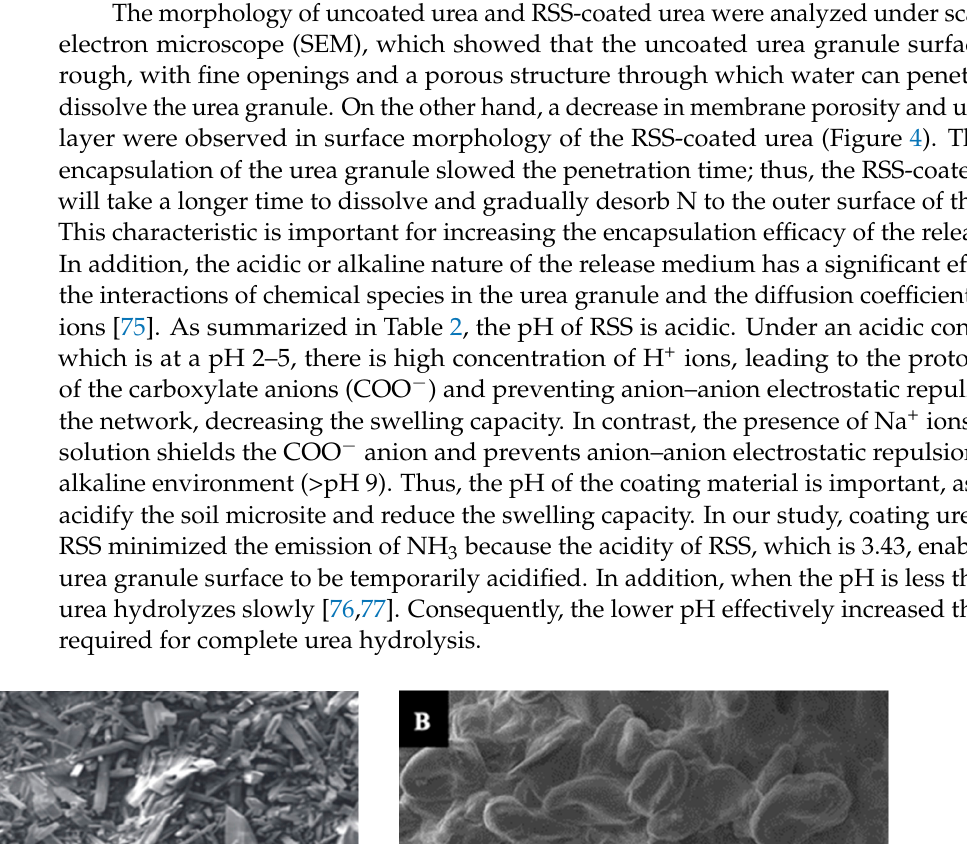
Figure 5. Di ff usion mechanism of nitrogen released from coated urea. After the release of NH 4+ in the soil, Figure 6 depicts the availability of NH 4+ for plant uptake, leading to increase in the NUE and minimizing the frequency of N fertilizer ap- plication. In addition, the coated urea mitigates N loss through the volatilization of NH 3 and the emission of nitrous oxide (N 2 O) in such a way that the coating serves as a nitri fi - cation inhibitor, which reduces the rate of nitri fi cation of NH 4+ to NO 3 − . Thus, N 2 O and nitric oxide (NO) emissions, NO 3 − leaching and/ or run-o ff , and the denitri fi cation of NO 3 − are reduced during this process. The mechanisms of N release from the coated urea take place in three di ff erent stages, such as the lag, linear, and decay regions, while the un- coated urea follows a linear trend (Figure 6). In the lag region, water in the soil penetrates the coating and a small fraction of urea fertilizer is dissolved. The vapor pressure gradient